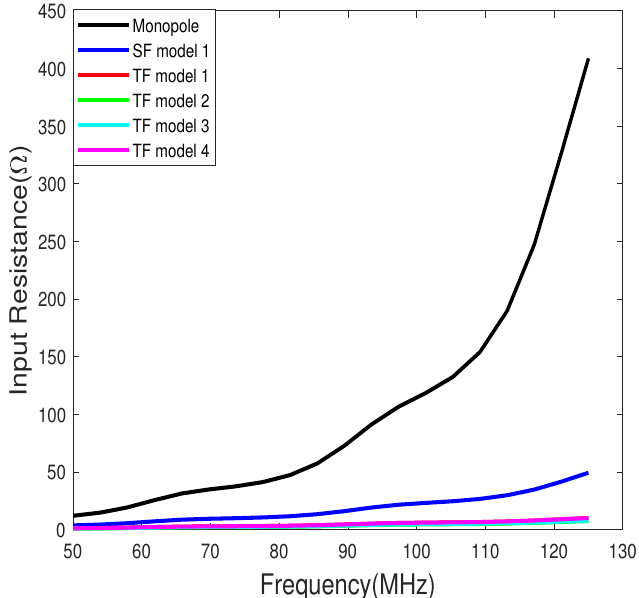
Figure 23. Input resistance of the two-fold antenna models from